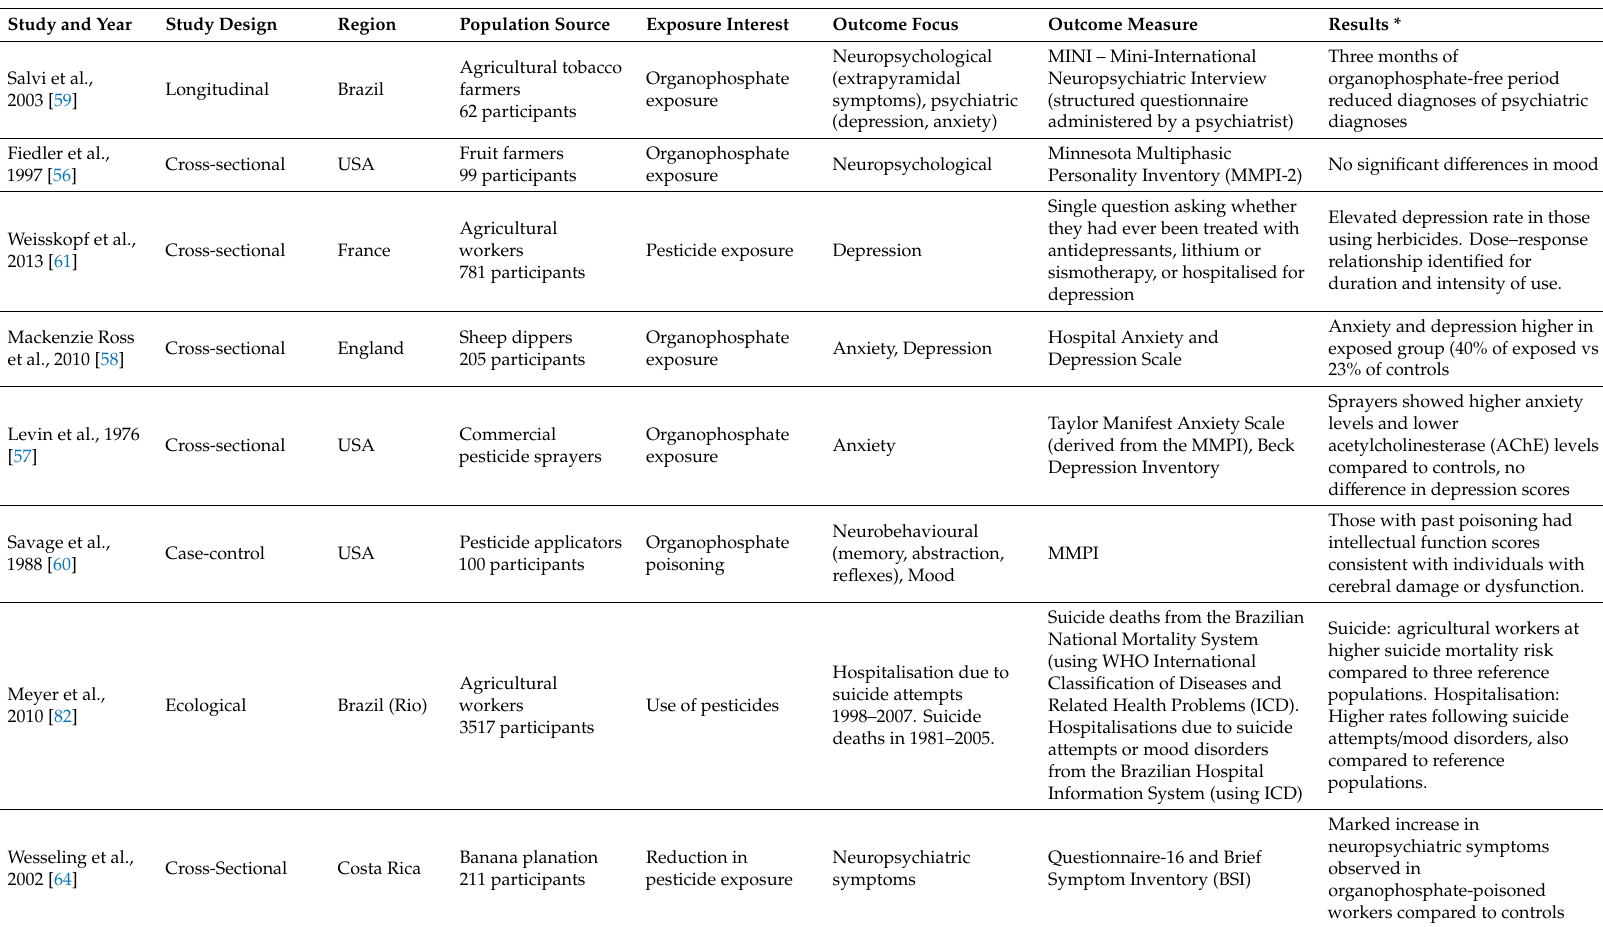
Table 1. Characteristics of the studies published on pesticide exposure and e ff ects on neurobehavioural or psychiatric disturbances in those in agricultural occupations. Study and